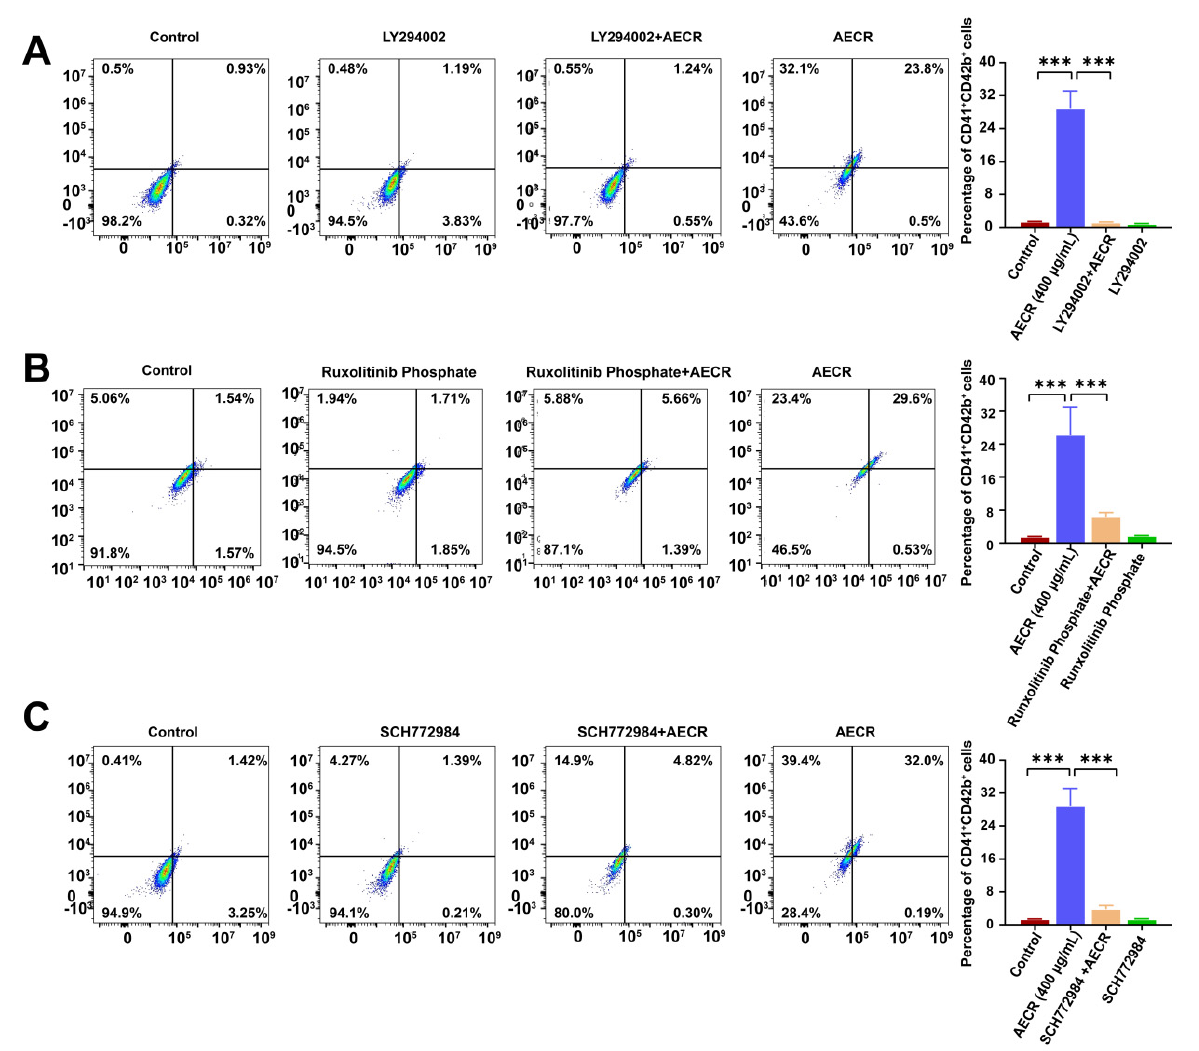
Figure 8. Flow cytometry was used to detect the content of CD41 and CD42b after K562 cells were incubated with inhibitors or AECRs for 4 days. The groups were set as follows: the control group, the AECR (400 μ g/mL) group, the inhibitor group, and the inhibitor + AECR (400 μ g/mL) group. These inhibitors were ( A ) LY294002, ( B ) ruxolitinib phosphate, and ( C ) SCH772984. On the right, this statistical histogram depicts the CD41 + CD42b + cell proportion in each group. The values represent the means ± standard deviations (n = 3). *** p < 0.001 versus the control group. AECRs: aqueous extracts of Cibotii rhizoma.